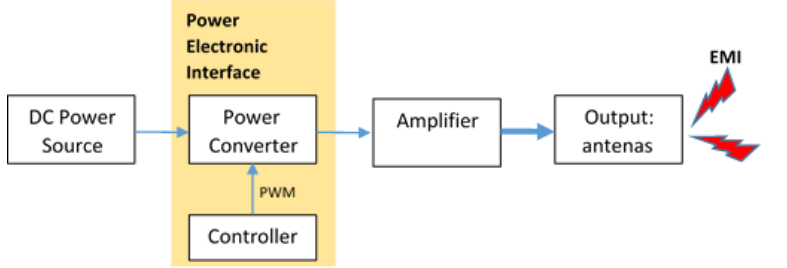
Figure 14. Testing source of electromagnetic interference.